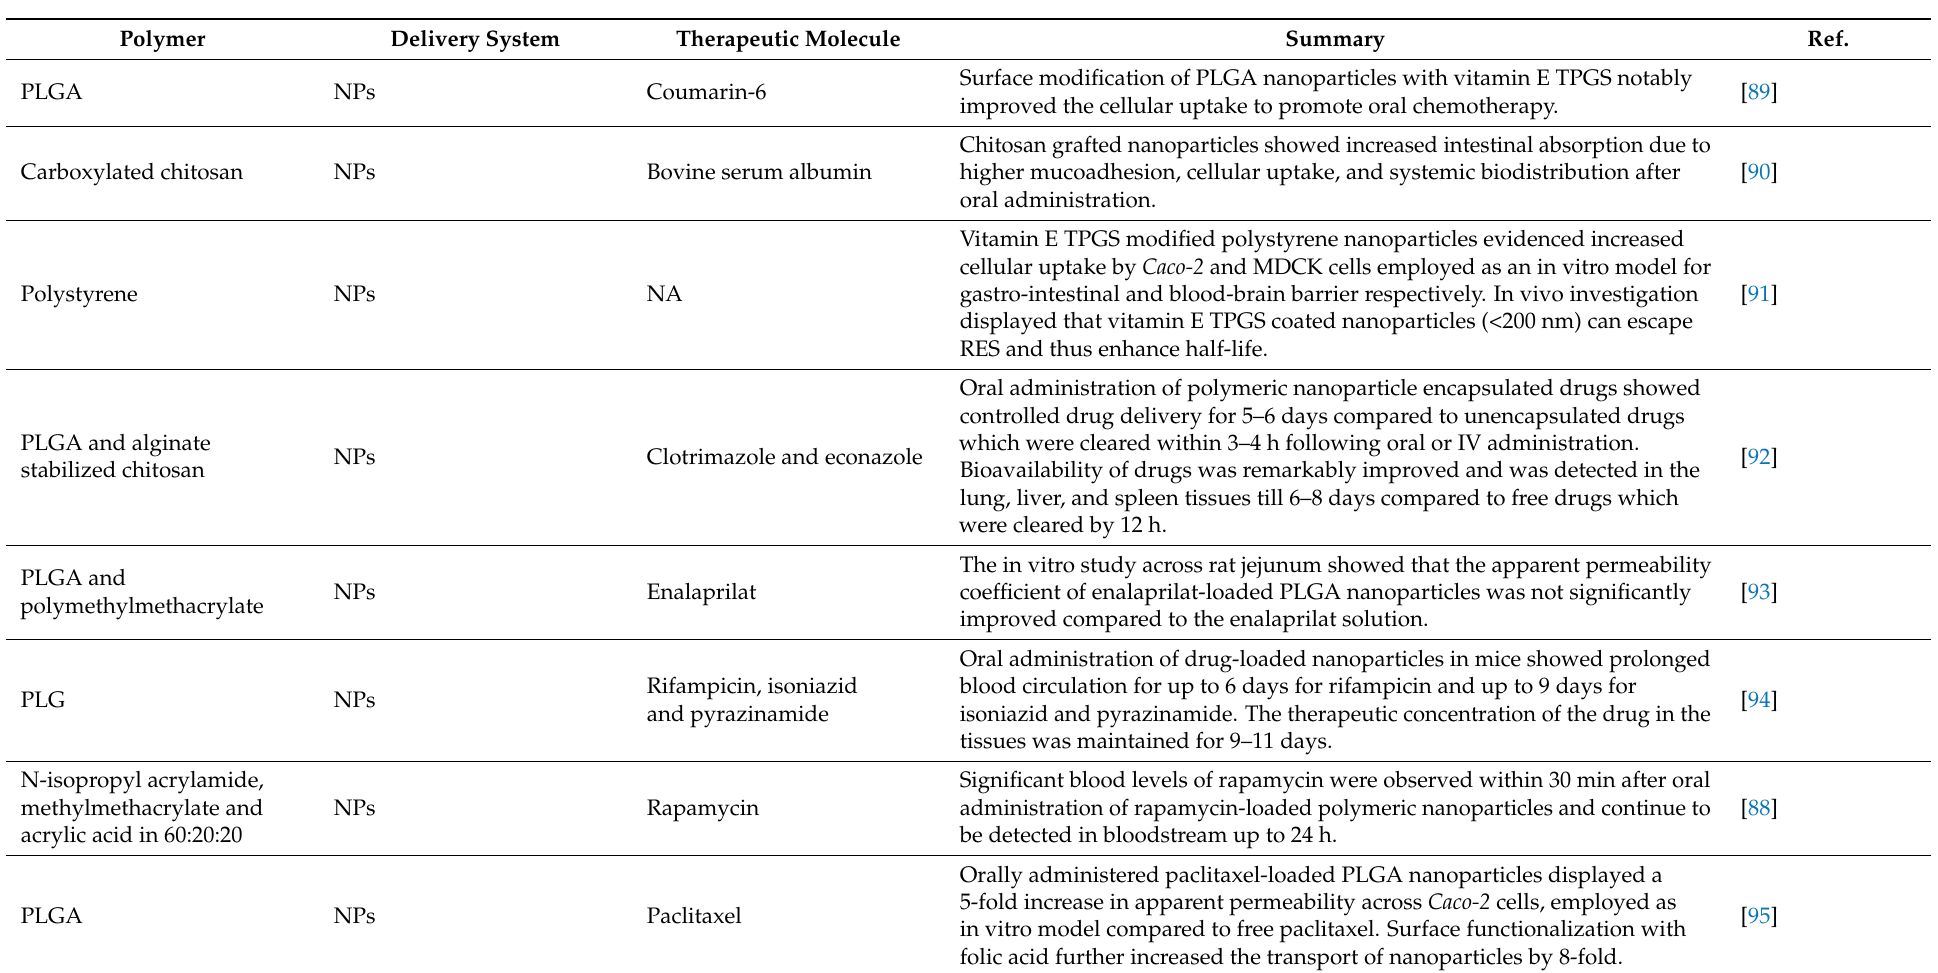
Table 2. Various nanopolymers employed as nanocarriers for oral delivery of drugs, peptides, and